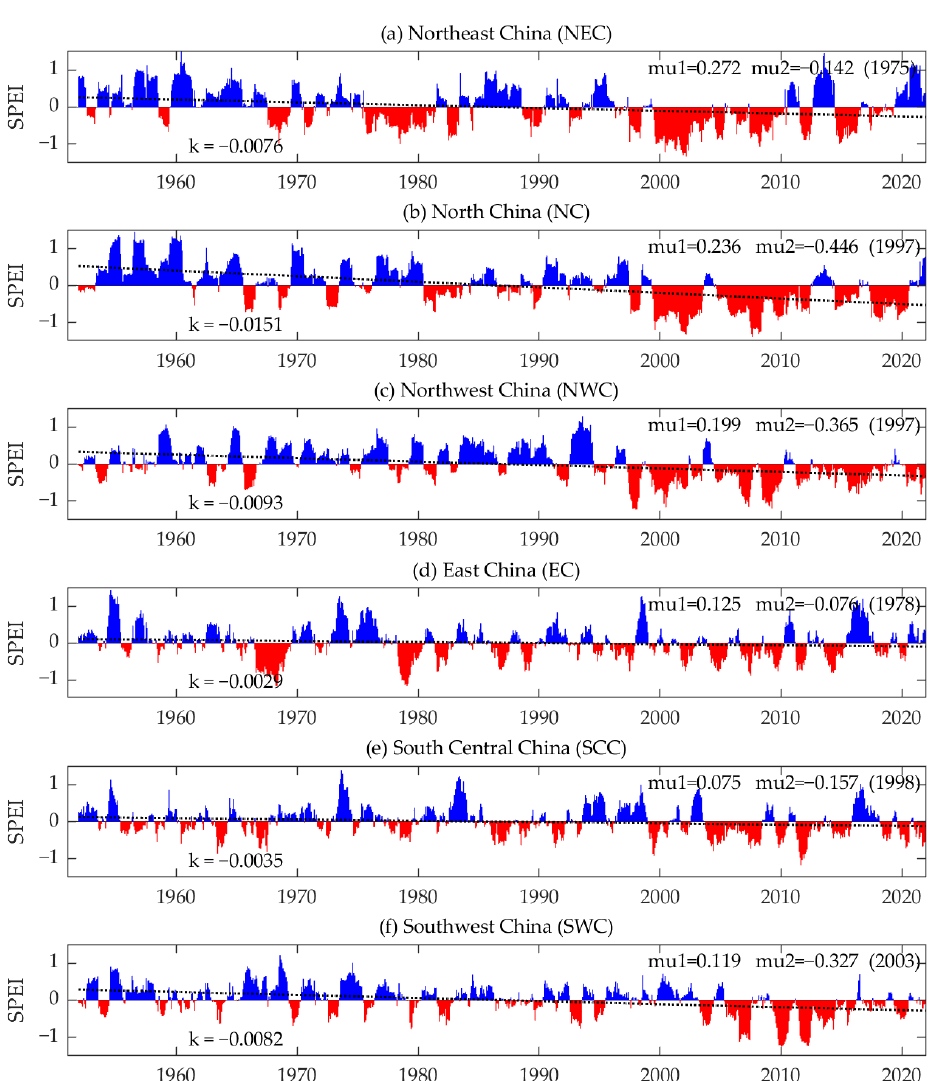
Figure 2. Temporal evolution of meteorological droughts based on the 12-month time window SPEI for six sub-regions in China during the period 1951–2021: ( a ) Northeast China (NEC); ( b ) North China (NC); ( c ) Northwest China (NWC); ( d ) East China (EC); ( e ) South Central China (SCC); ( f ) Southwest China (SWC). Red refers to dryness (SPEI − ); blue refers to wetness (SPEI+). The black dotted line denotes the linear trend fit by the least-squares method; k denotes the trend slope (unit in month − 1 ). mu1 denotes pre-mutation (positive value), and mu2 denotes post-mutation (negative value). Numbers in parentheses indicate the year of mutation (from the Pettitt